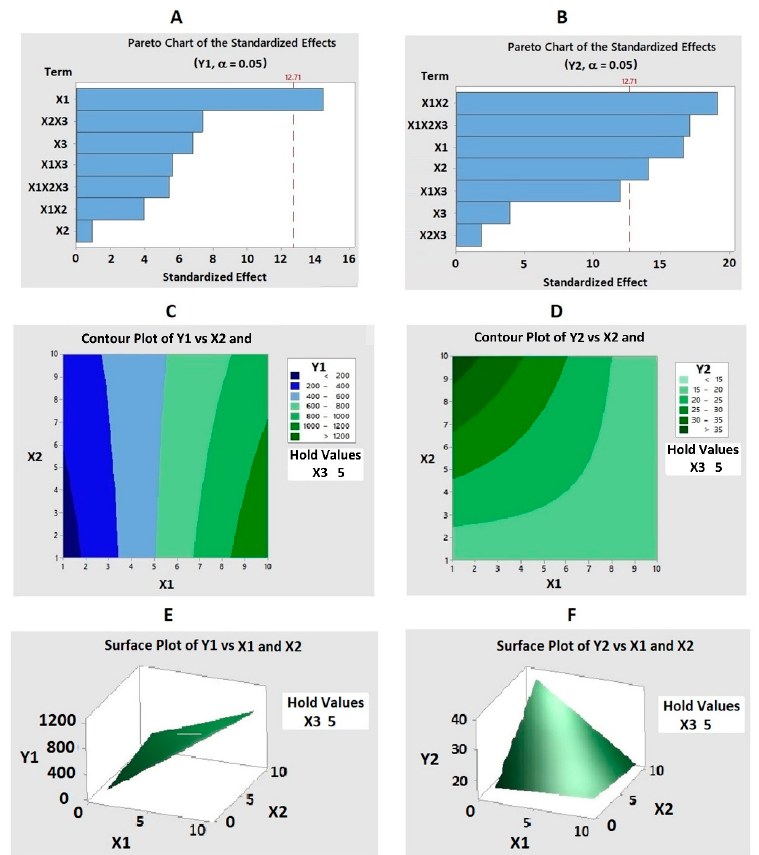
Figure 1. Pareto charts ( A and B ) showing the vertical dashed reference line of significance ( p < 0.05). Contour plots ( C and D ) and three-dimensional (3D) response surface plots ( E and F ) for Y1 and Y2, showing the effects of X1, X2, and X3, as well as their combined effects on Y1 and Y2. Abbreviations: X1, FLV concentration (mM); X2, TAT concentration (mM); X3, pH of the medium Y1, particle size (nm); Y2, zeta potential (mV); the interaction term between the factors X1X1, X2X2, and X3X3 are the quadratic terms between the factors; X1X2, X1X3, X2X3, and X1X2X3 are the interaction terms of the investigated factors.